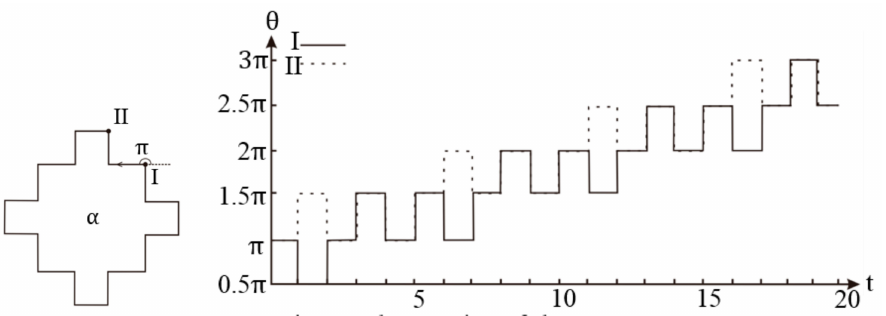
Figure 1. Turning angle function of shape α with different start